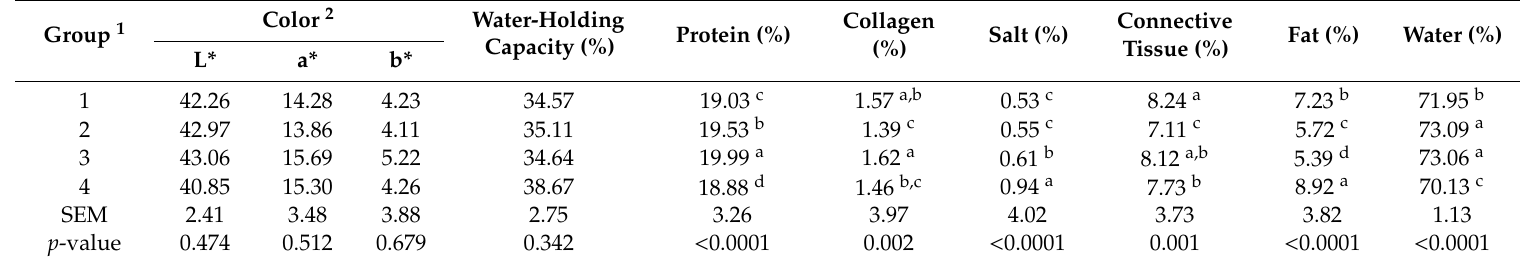
Table 8. Physicochemical parameters of leg muscles from 77-day-old broiler